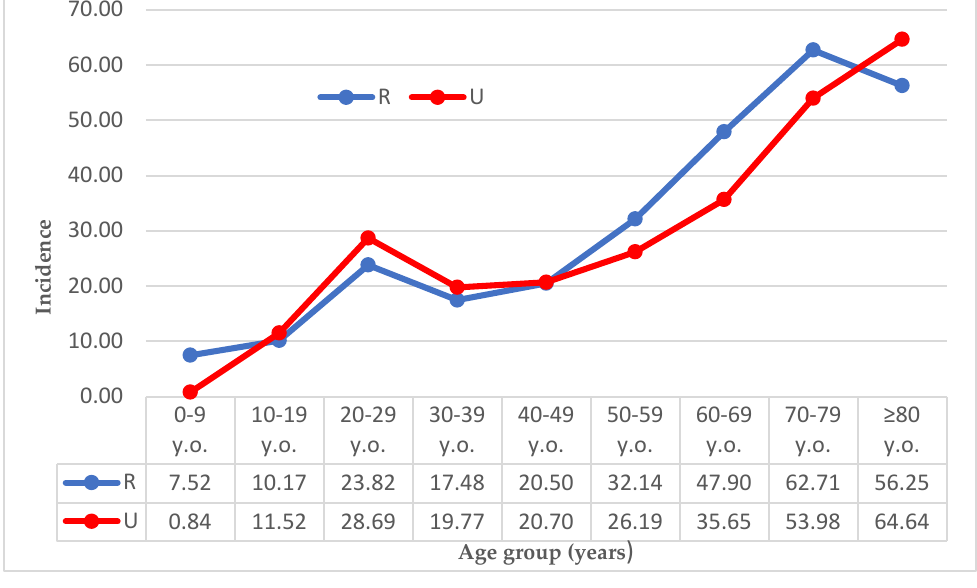
Figure 4. Incidence rate (nr. of cases/100,000 person-years) of dislocations by age group in rural and urban populations. Legend: R, rural population; U, urban